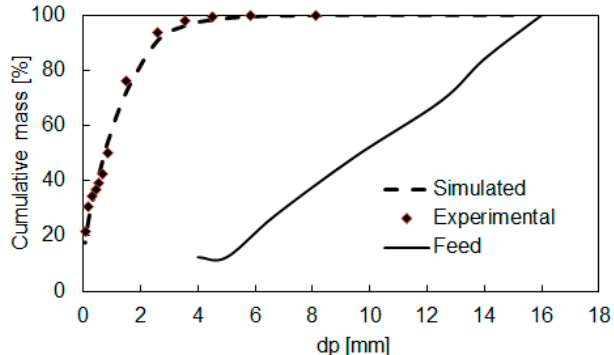
Figure 21. Simulation results of the test PT-1 using back-calculated model parameters.